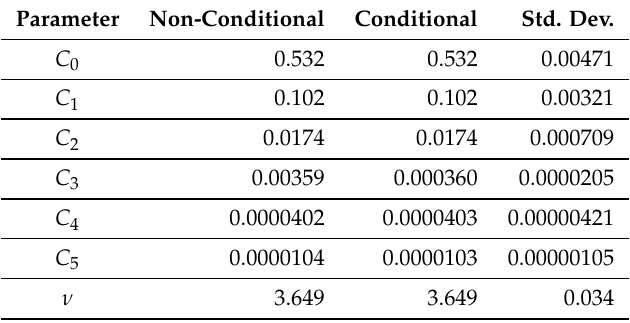
Table 3. Estimated parameters for the PHARCH(5)model with aggregations 1, 4, 96, 480 and 1920 for the Euro-Dollar series, using Griddy-Gibbs